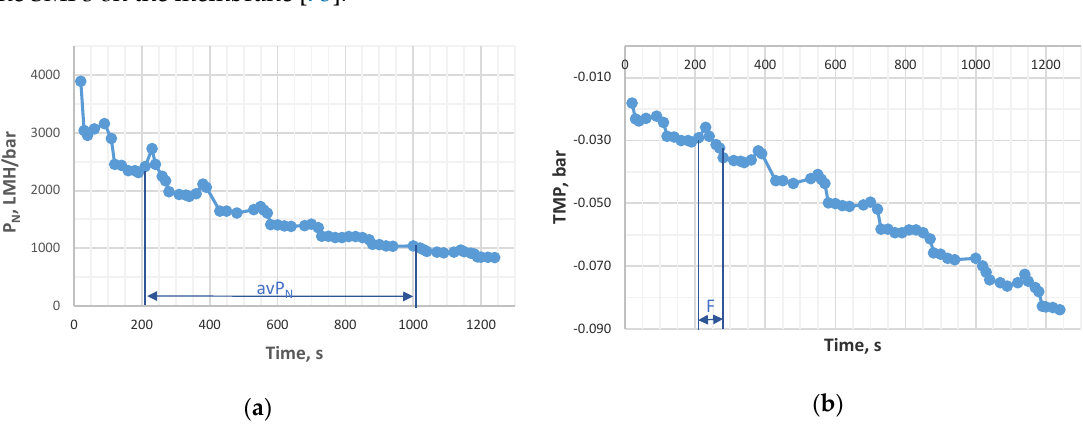
Figure 6. Average normalized permeability ( a ) and filtration time ( b ), determined from the total recycle test.